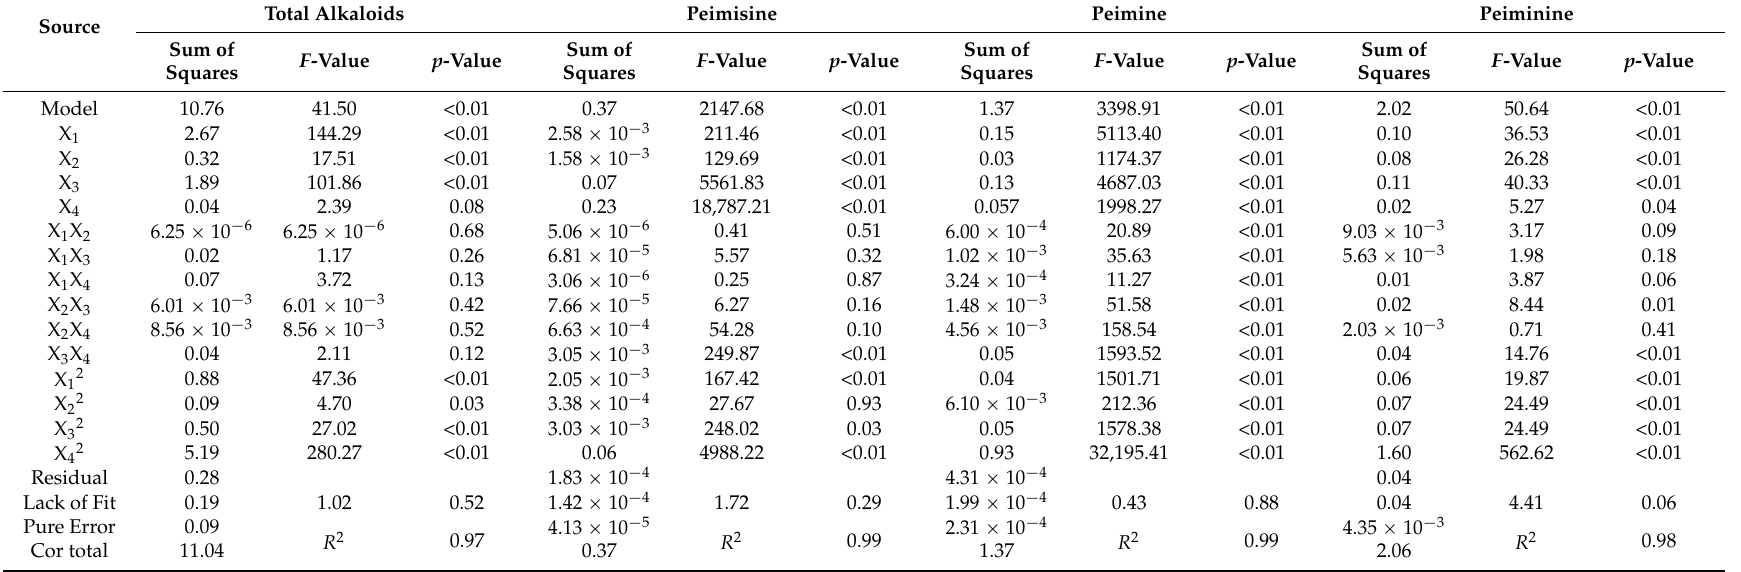
Table 2. Analysis of variance for the response surface quadratic